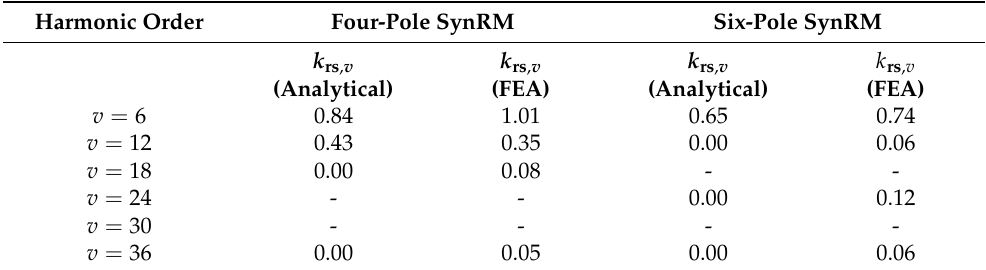
Table 7. Torque ripple harmonic component reduction as a result of three-step skewing. The 3D results are considered, and relevant harmonic components analyzed.